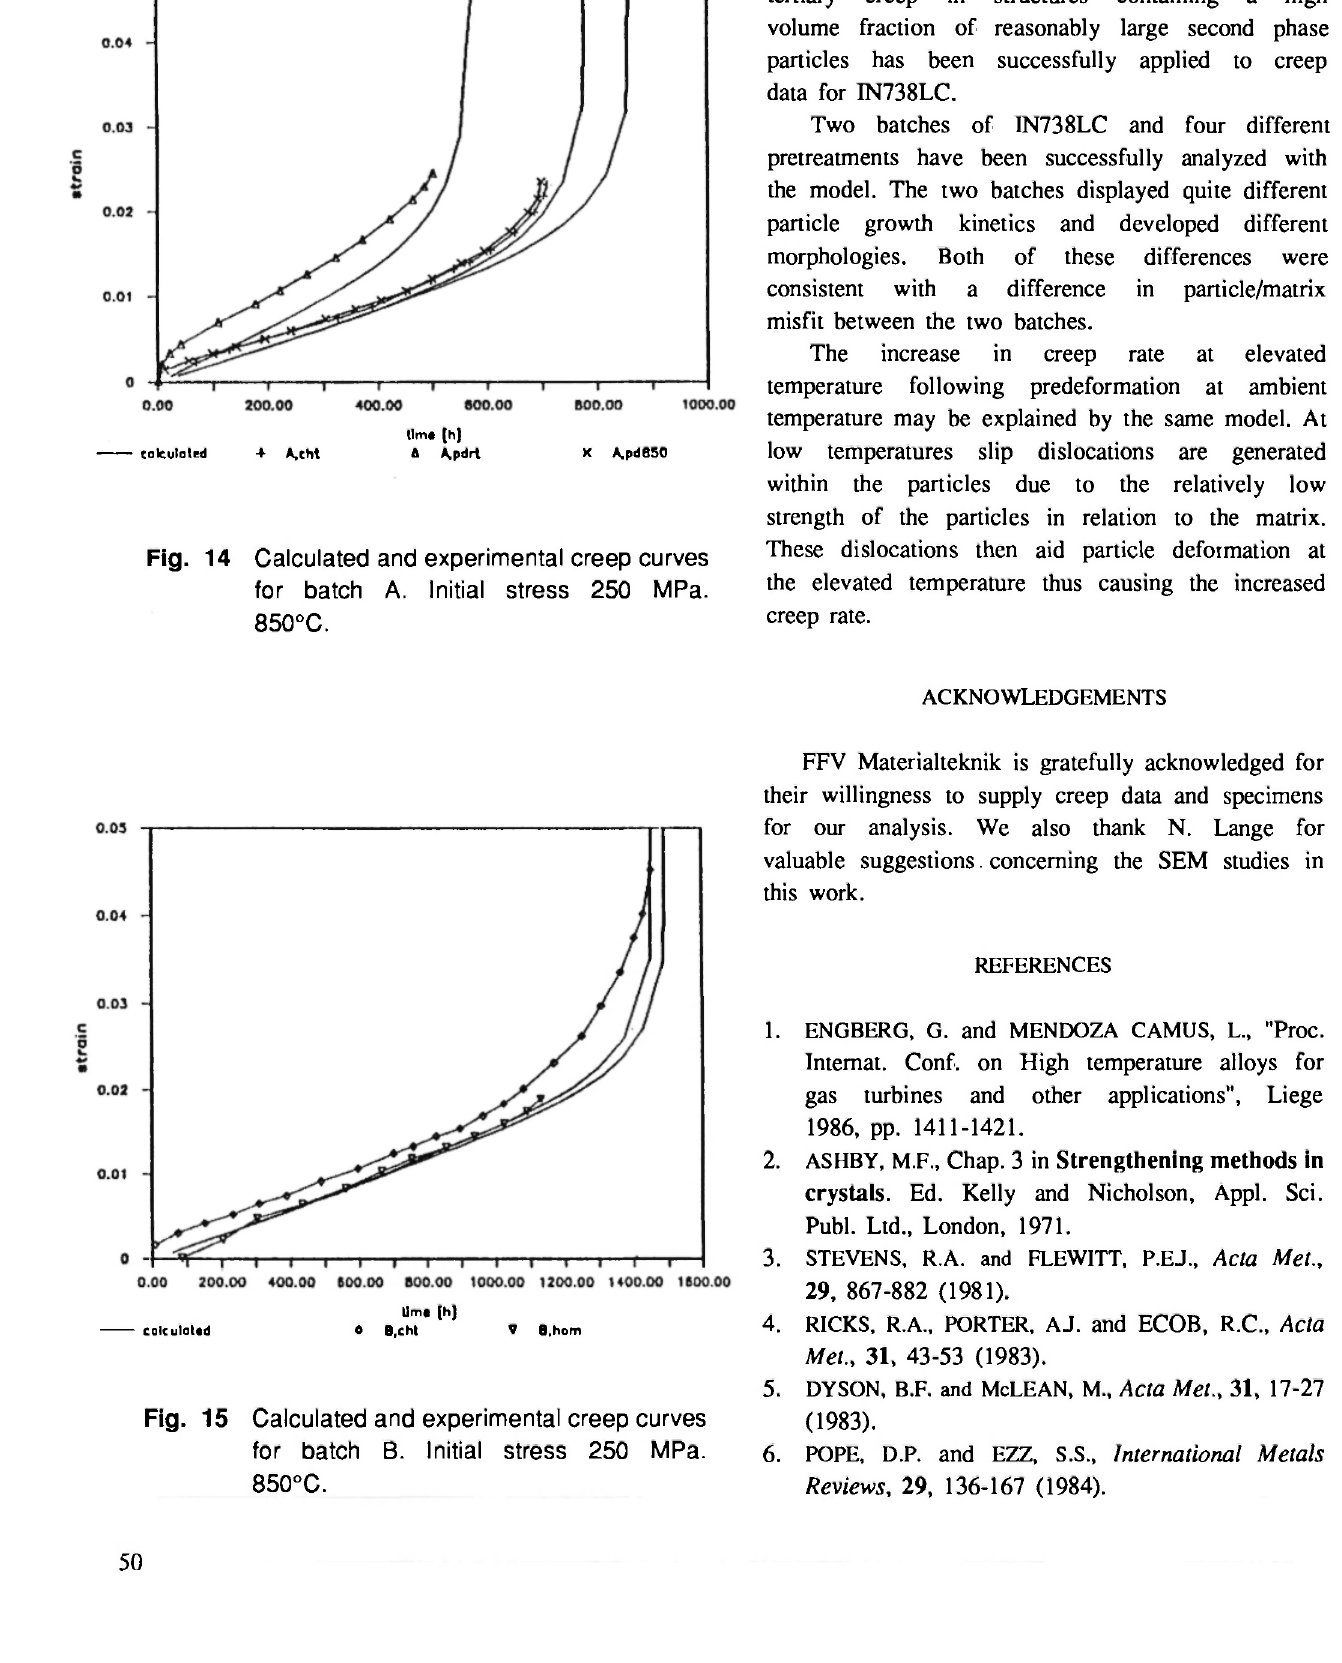
Fig. 14 Calculated and experimental creep curves for batch A. Initial stress 250 MPa.